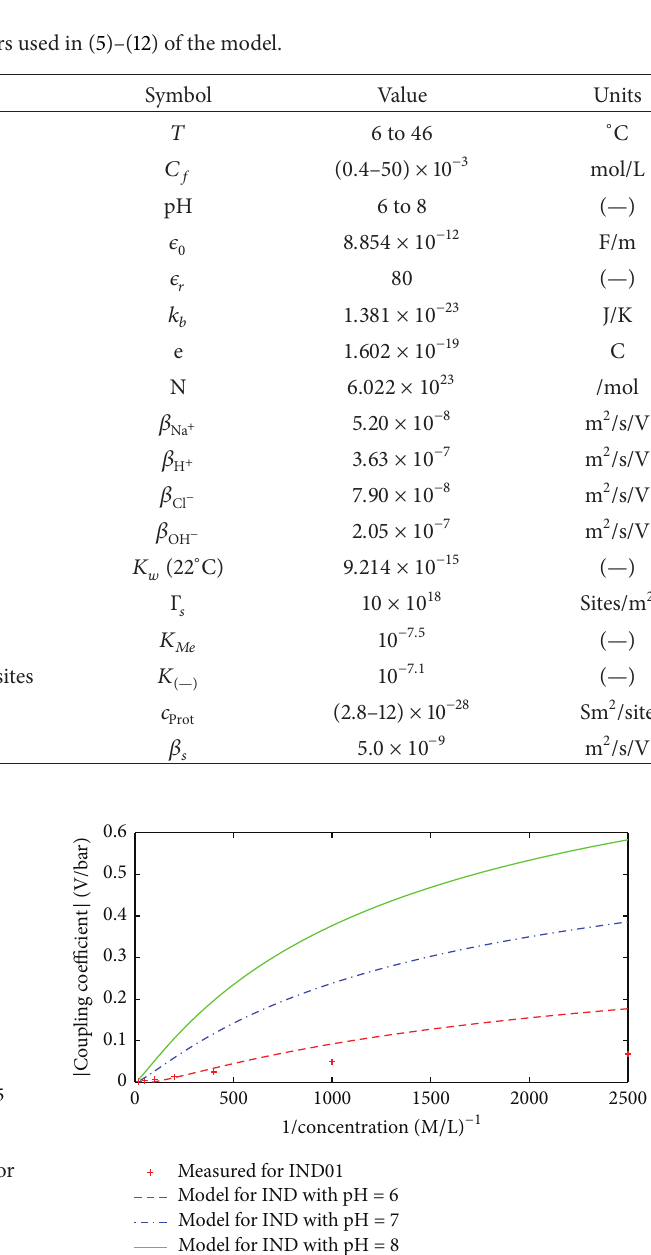
= 3×10 −28 S m 2 /site Prot